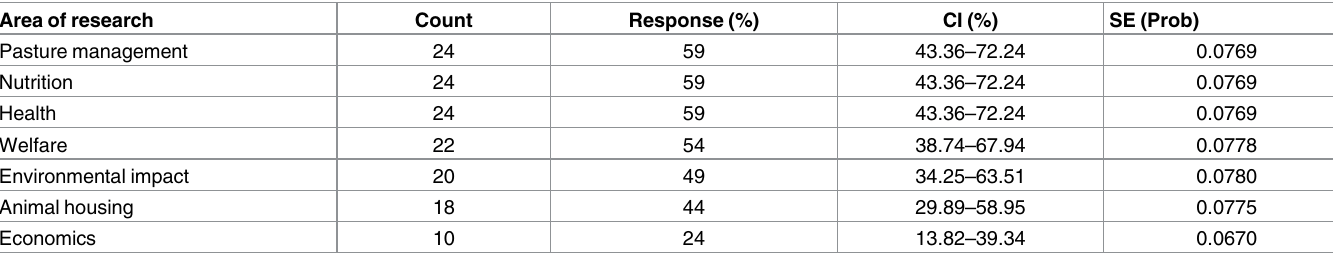
Table 8. Researchareasof interest to respondent